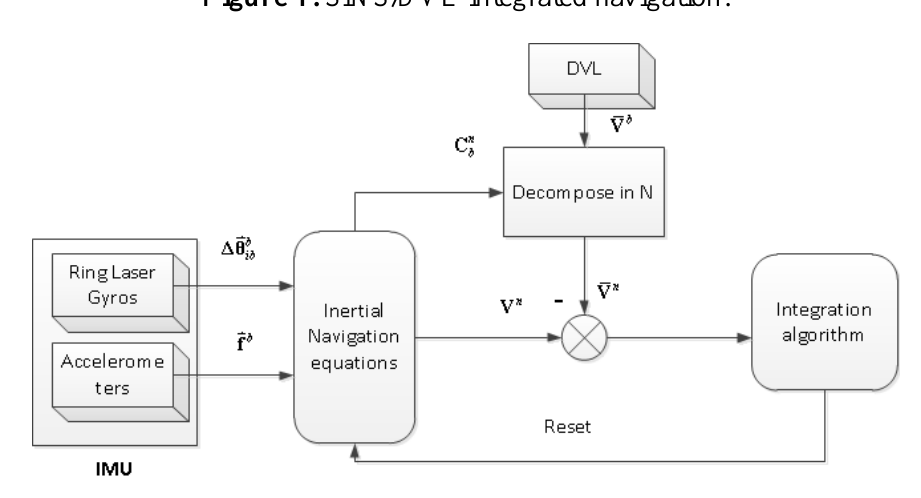
Figure 1. SINS/DVL integrated